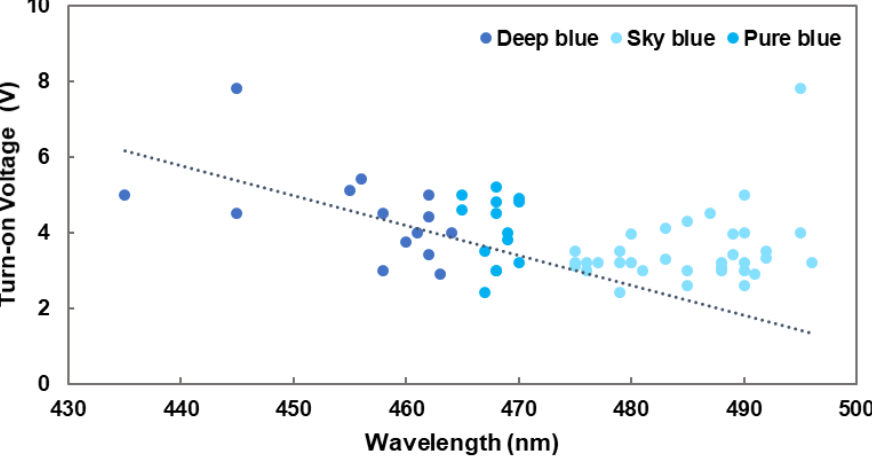
Figure 4. The trend of turn-on voltage along with their emission wavelengths for some representa- tive PeLEDs. tive